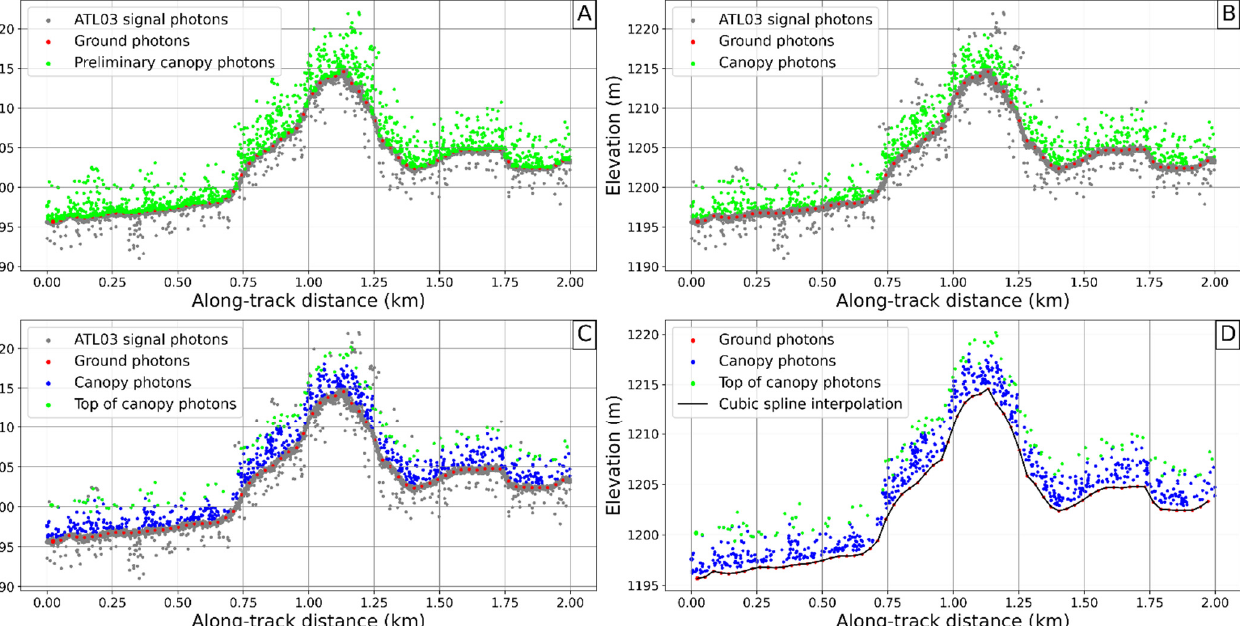
gt1l, daytime acquisition with ID: ATL03_20190116100224_02890214_004_01: ( A ) Ground photons